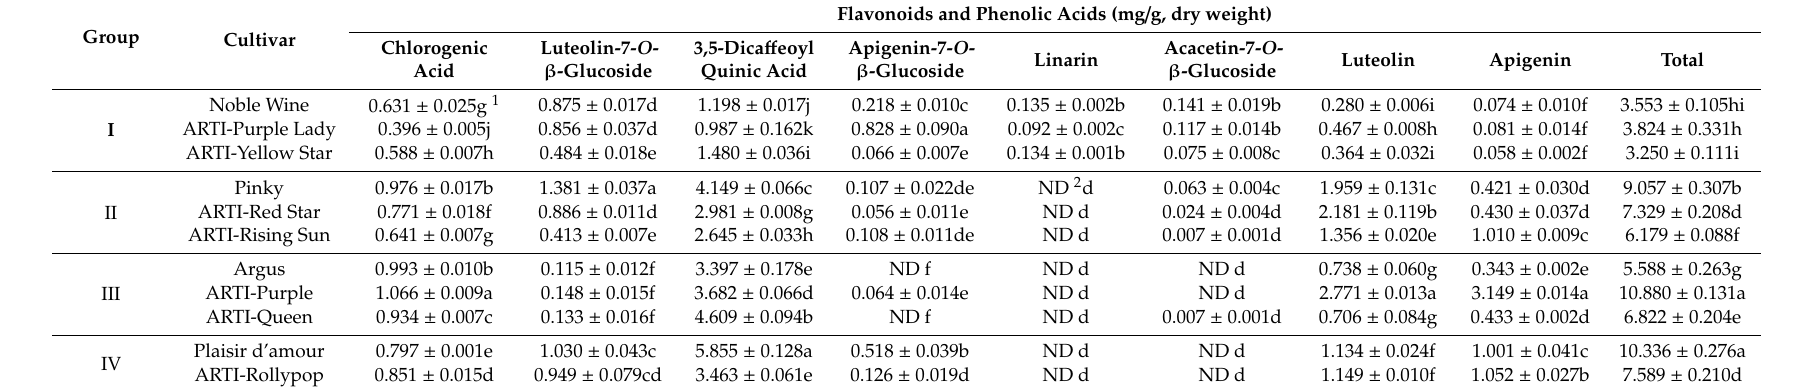
Table 1. The contents of flavonoid and phenolic acid in the chrysanthemum